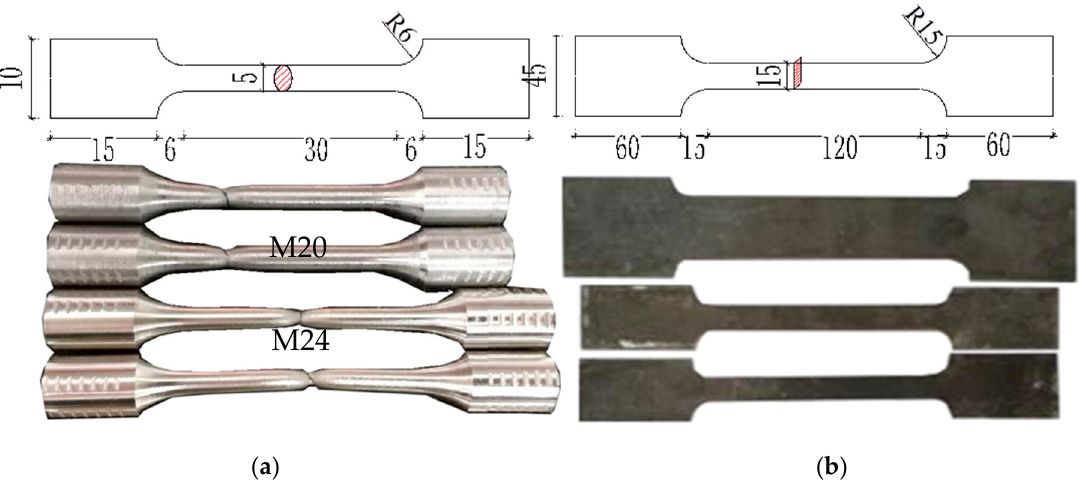
Figure 3. Design dimensions of material test samples (mm): ( a ) Bolt material test samples; ( b ) Steel sheet test specimens. Table 2. Material properties of specimens.